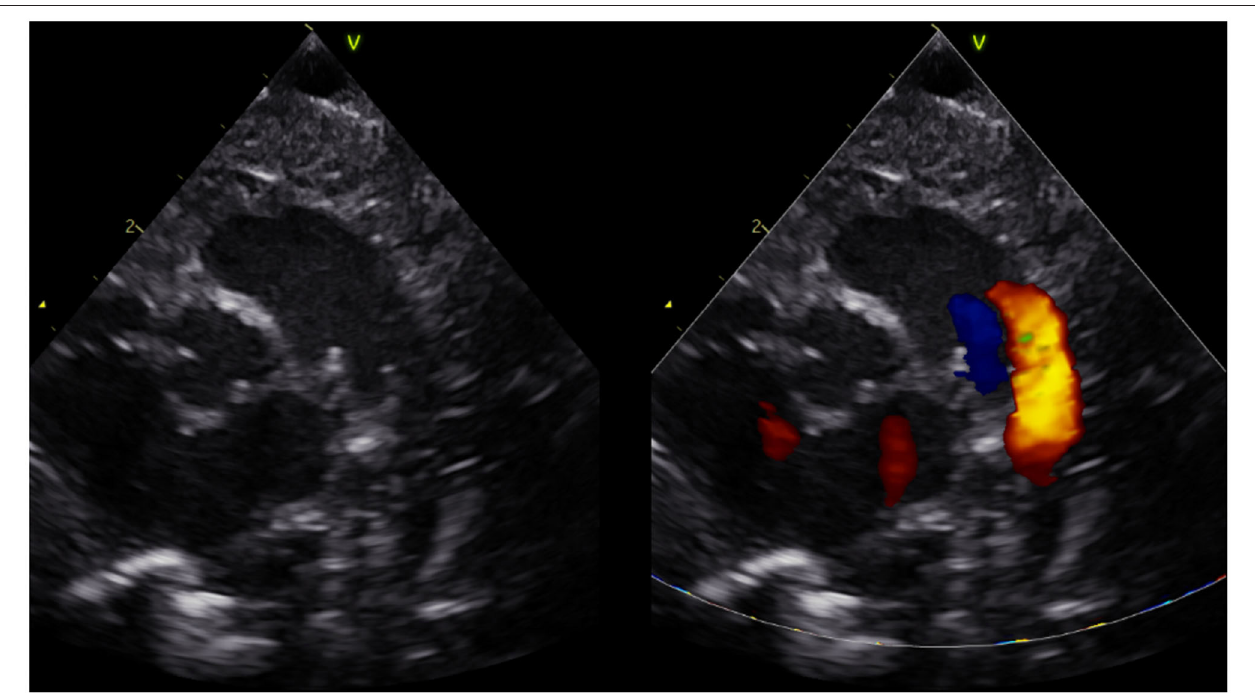
FIGURE 1 | Short axis parasternal view of ductus arteriosus and pulmonary arteries (three vessel view).